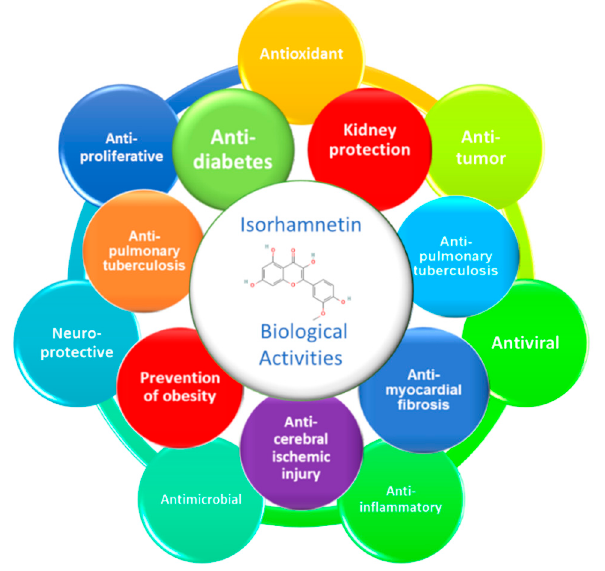
Figure 3. Overview of biological activities of isorhamnetin. NB. Circles do not represent any hierarchical relationship.